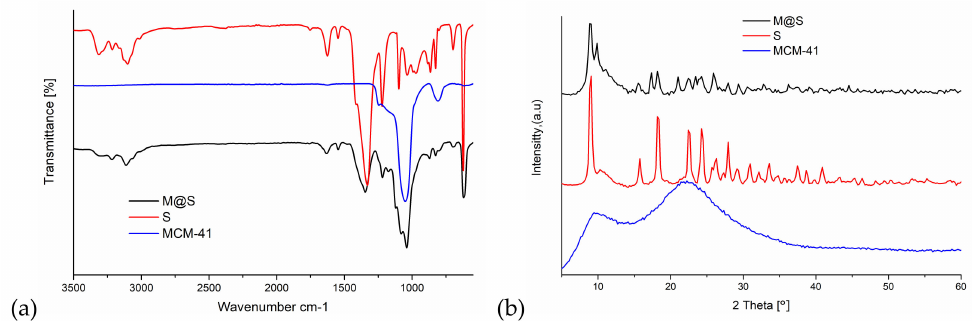
Figure 1. ( a ) IR spectra and ( b ) powder X-ray diffractograms (PXRD) patterns of compound S , hybrid material M@S, and MCM-41.